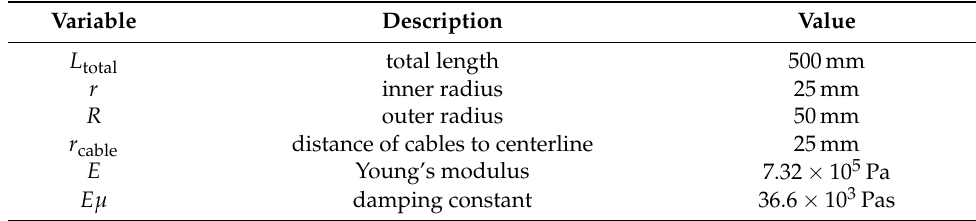
Table 2. Parameters of the simulation